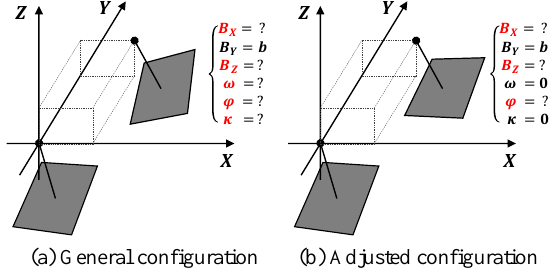
Figure 1. Perspective transformation estimation considering characteristics of flight geometry.